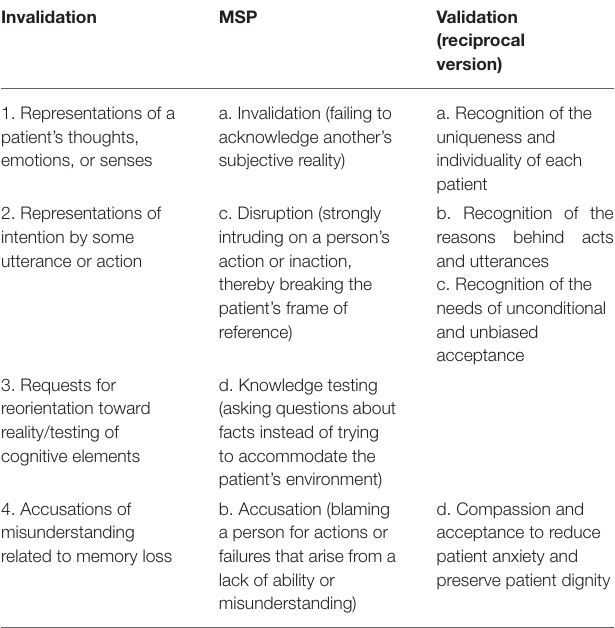
TABLE 1 | Categories of invalidation, from Van Wheert et al. (2008) and Feil (1993).